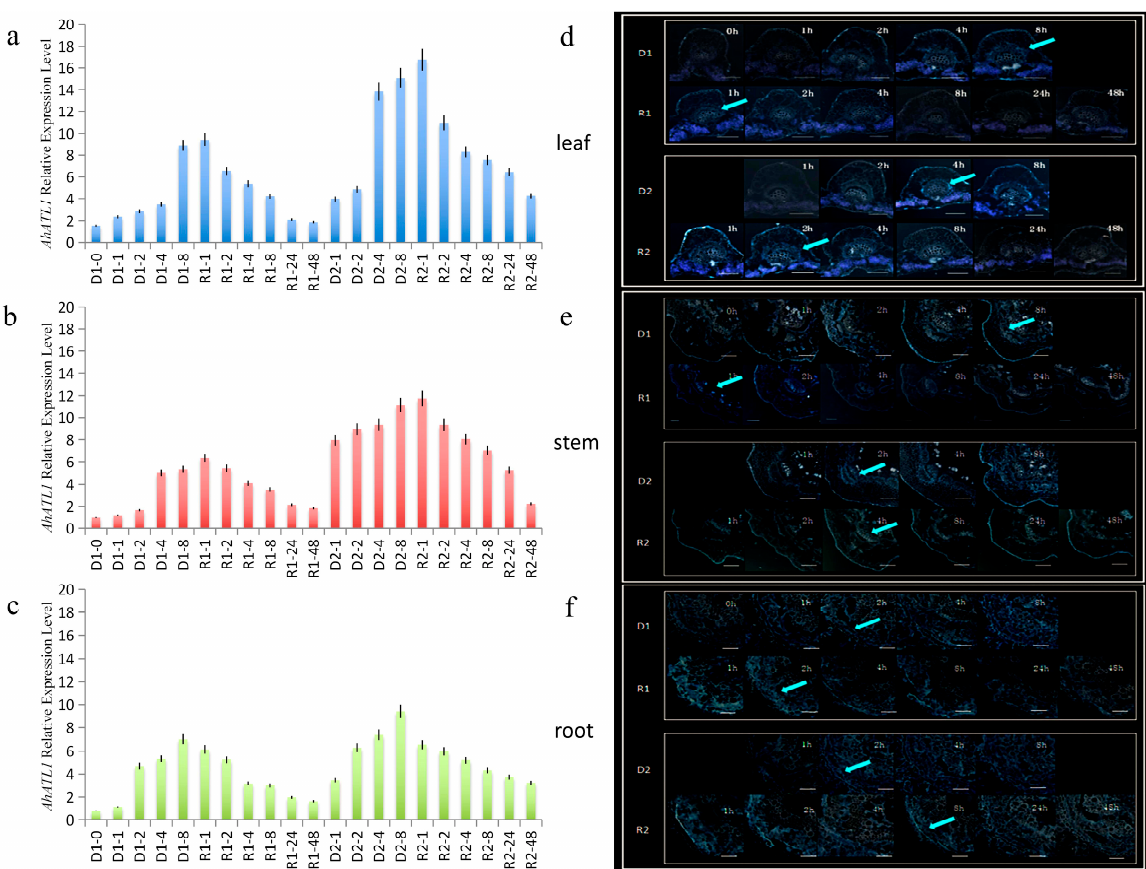
Figure 1. The AhATL1 expression and AhATL1 distribution analyses in peanuts during the drought stress memory process evaluated with real-time quantitative PCR (RT-qPCR) and the immunofluorescence localization assays. The time points of the first drought (D1)-1 to the second drought recovery (R2)-48 were sampled to observe the expression and distribution-changing trend. The untreated group was used as the control (D1-0). ( a – c ) Expression analyses of AhATL1 in peanut leaves, stems, and roots during the drought stress memory process. UBQ10 was used as an internal control. The mean and SD (standard deviation) were obtained from more than three biological replicates. ( d – f ) AhATL1 immunostaining of the leaves, stems, and roots following the same treatment regime described for a. The control samples were treated with PBS; blue fluorescence (arrows) indicates the presence of AhATL1; and no color indicates a lack of staining.